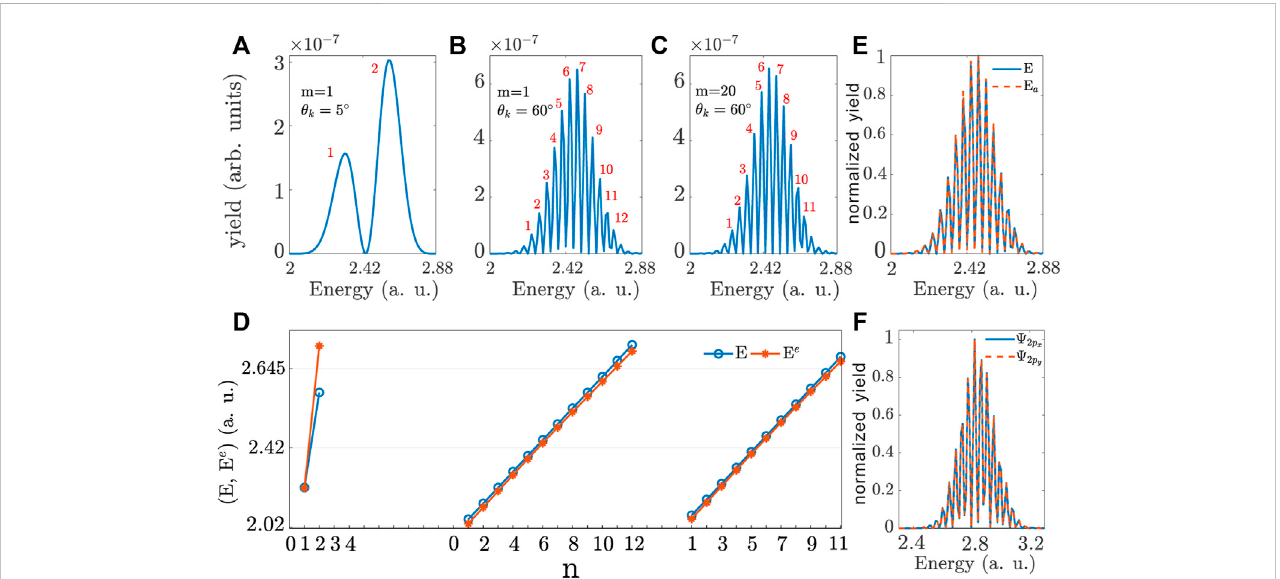
FIGURE 5 Theenergy spectraof1sstate ofahydrogenatomfor ϕ p = p z = 0with thePTAM andopeningangle ofthe X wave (A) m =1, θ k =5 ° , (B) m = 1, θ k =60 ° and (C) m = 20, θ k = 60 ° . The red integers represent the peak numbers of the energy spectra. (D) Comparison of E (blue line) and E e (red line) corresponding to the peaknumbersin (A – C) . E e istheevaluatedresultaccordingtoEq.16and E isthenumericalresult.Theunitsofphotoelectronyieldarearbitraryunits(arb.units) and the units of energy are a.u. (E) Comparison of the energy spectra of X wave ( E labeled by the blue solid line) and double circular plane-wave pulses with the same time-delay τ as that in Figure 3E ( E a labeled by the red dashed line). (F) Comparison of the energy spectra of 2p x , y orbitals corresponding to the PMDs in Figures 3G, H. The yield in (E) and (F) is normalized.